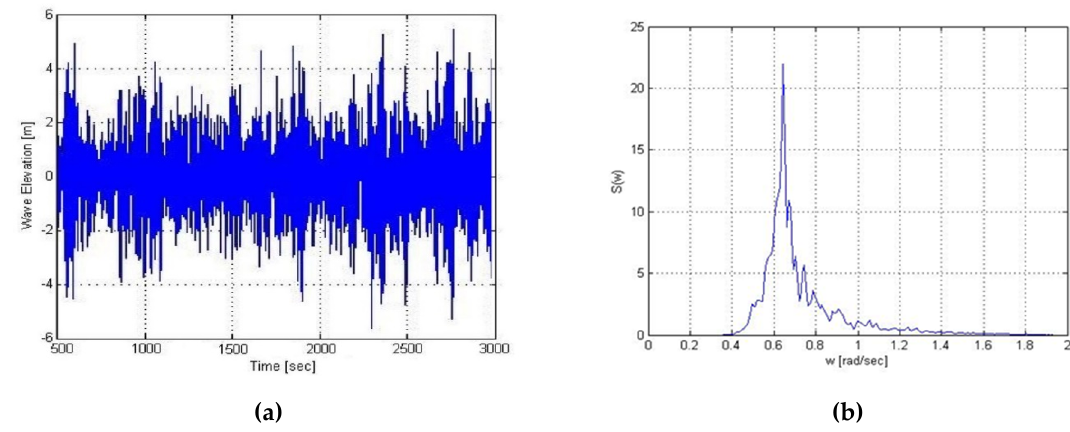
Figure 12. Environmental conditions for case 2: ( a ) Time series of wave elevation. ( b ) Wave spectrum.